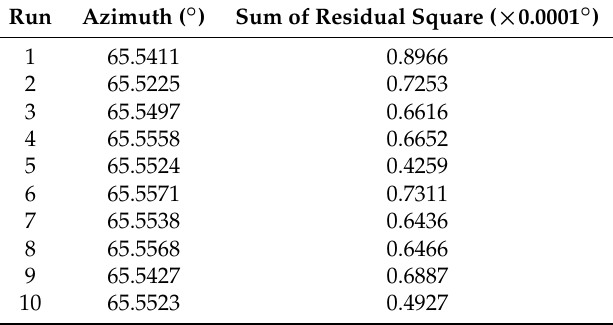
Table 3. Azimuth measurement results with n = 120.